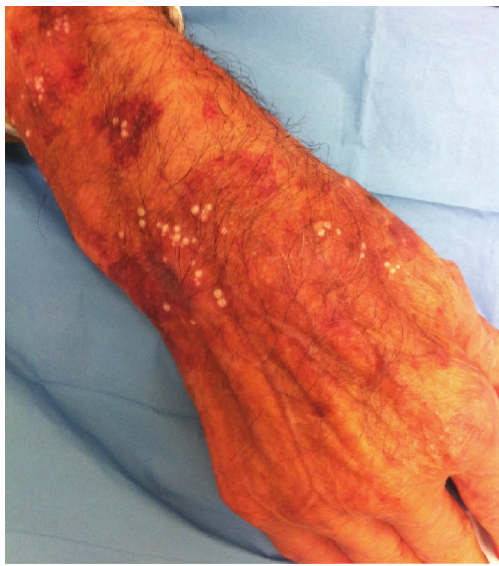
Figure 4: Purpura, milia and rubeosis steroidica induced by superpotent topical